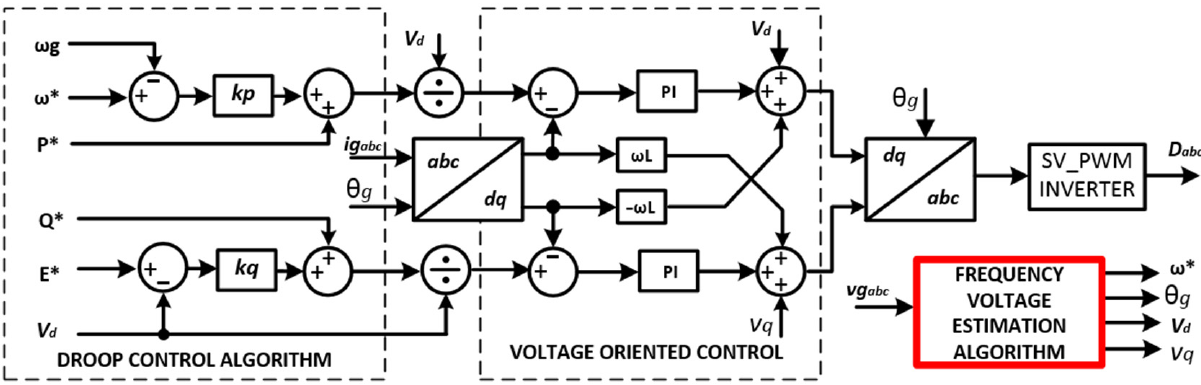
Figure 2. Droop Control of a Grid-Tied Inverter, where: P*, Q*—reference value of active, reactive power; E*, ω *—reference value of output voltage and system angular frequency; Vd, Vq—active and reactive voltage; ω g, θ g—real value of system angular frequency and phase angle; ig abc , vg abc —the instantaneous value of phase current and voltage; Kp, Kq—the droop coefficients; D abc —inverter duty cycle; and L—output filter induction.